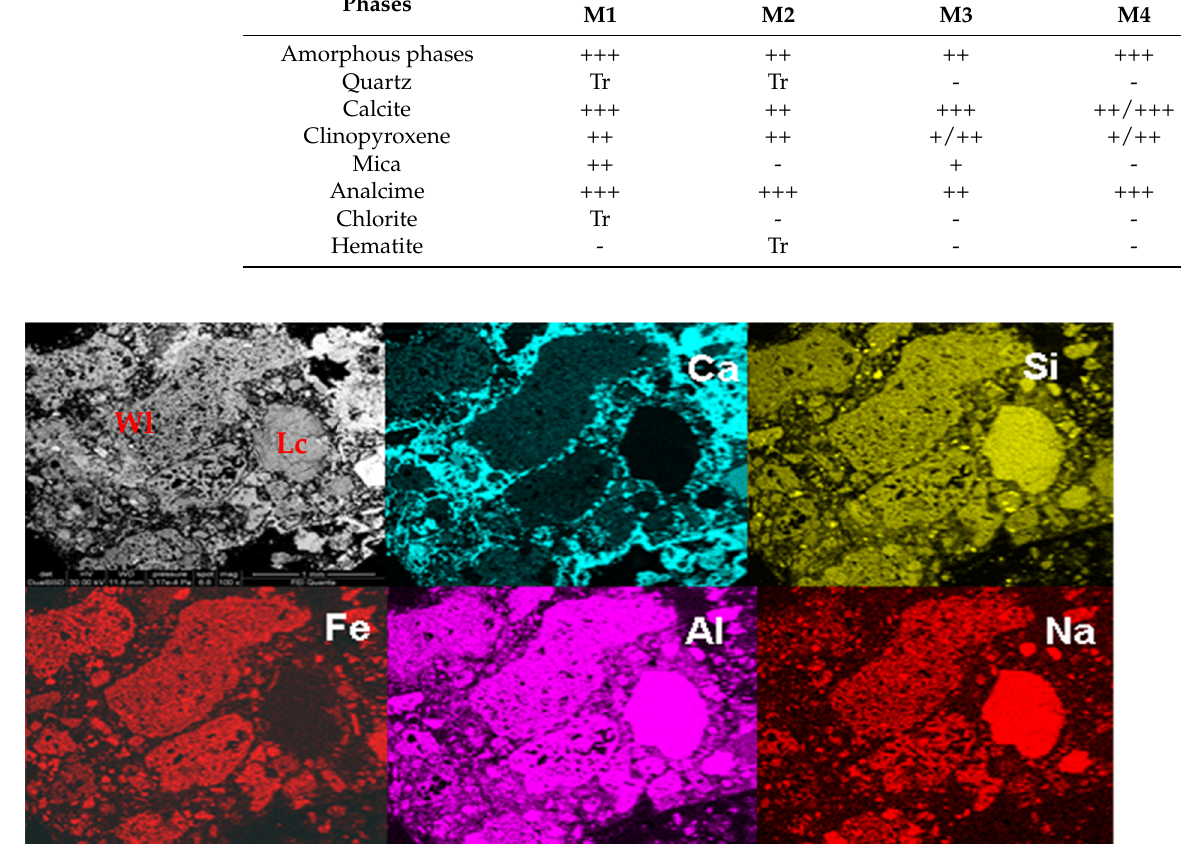
Figure 9. BSE image and X-ray maps of sample M1. Fragments of red pozzolan, a crystal of analcimized leucite (Lc) and lime lump (Wl) are indicated.